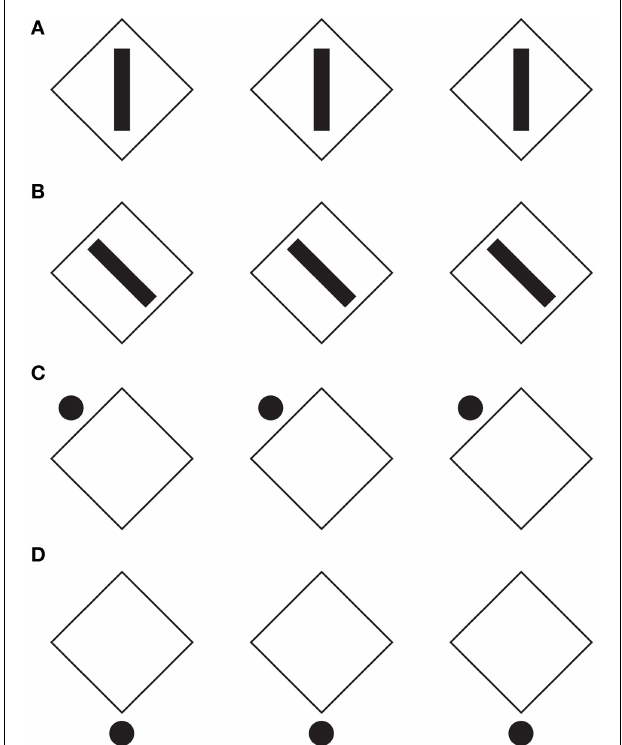
FIGURE 4 | The local directional shape organization creates diamonds (A,D) and rotated squares (B,C). For further details please see the text.